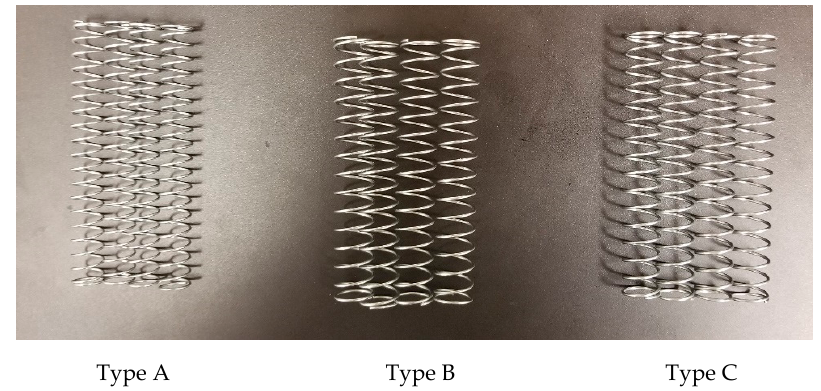
Figure 9. Three spring types used in the experiment.